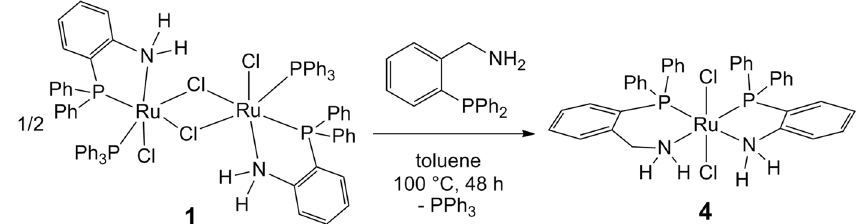
Figure 2. Synthesis of ruthenium complex 4 .